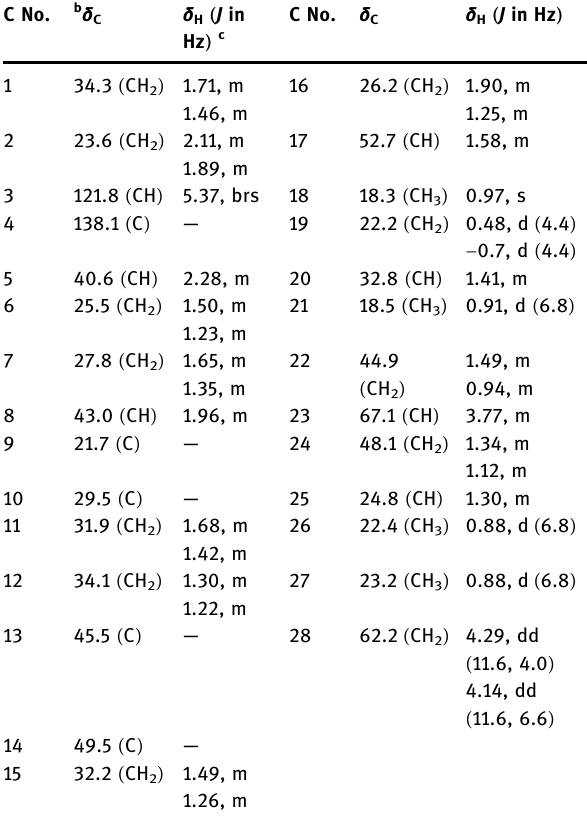
Table 1: 1 H and 13 C NMR ( 400 and 100 MHz, respectively ) spectral data of compound 1 in CDCl